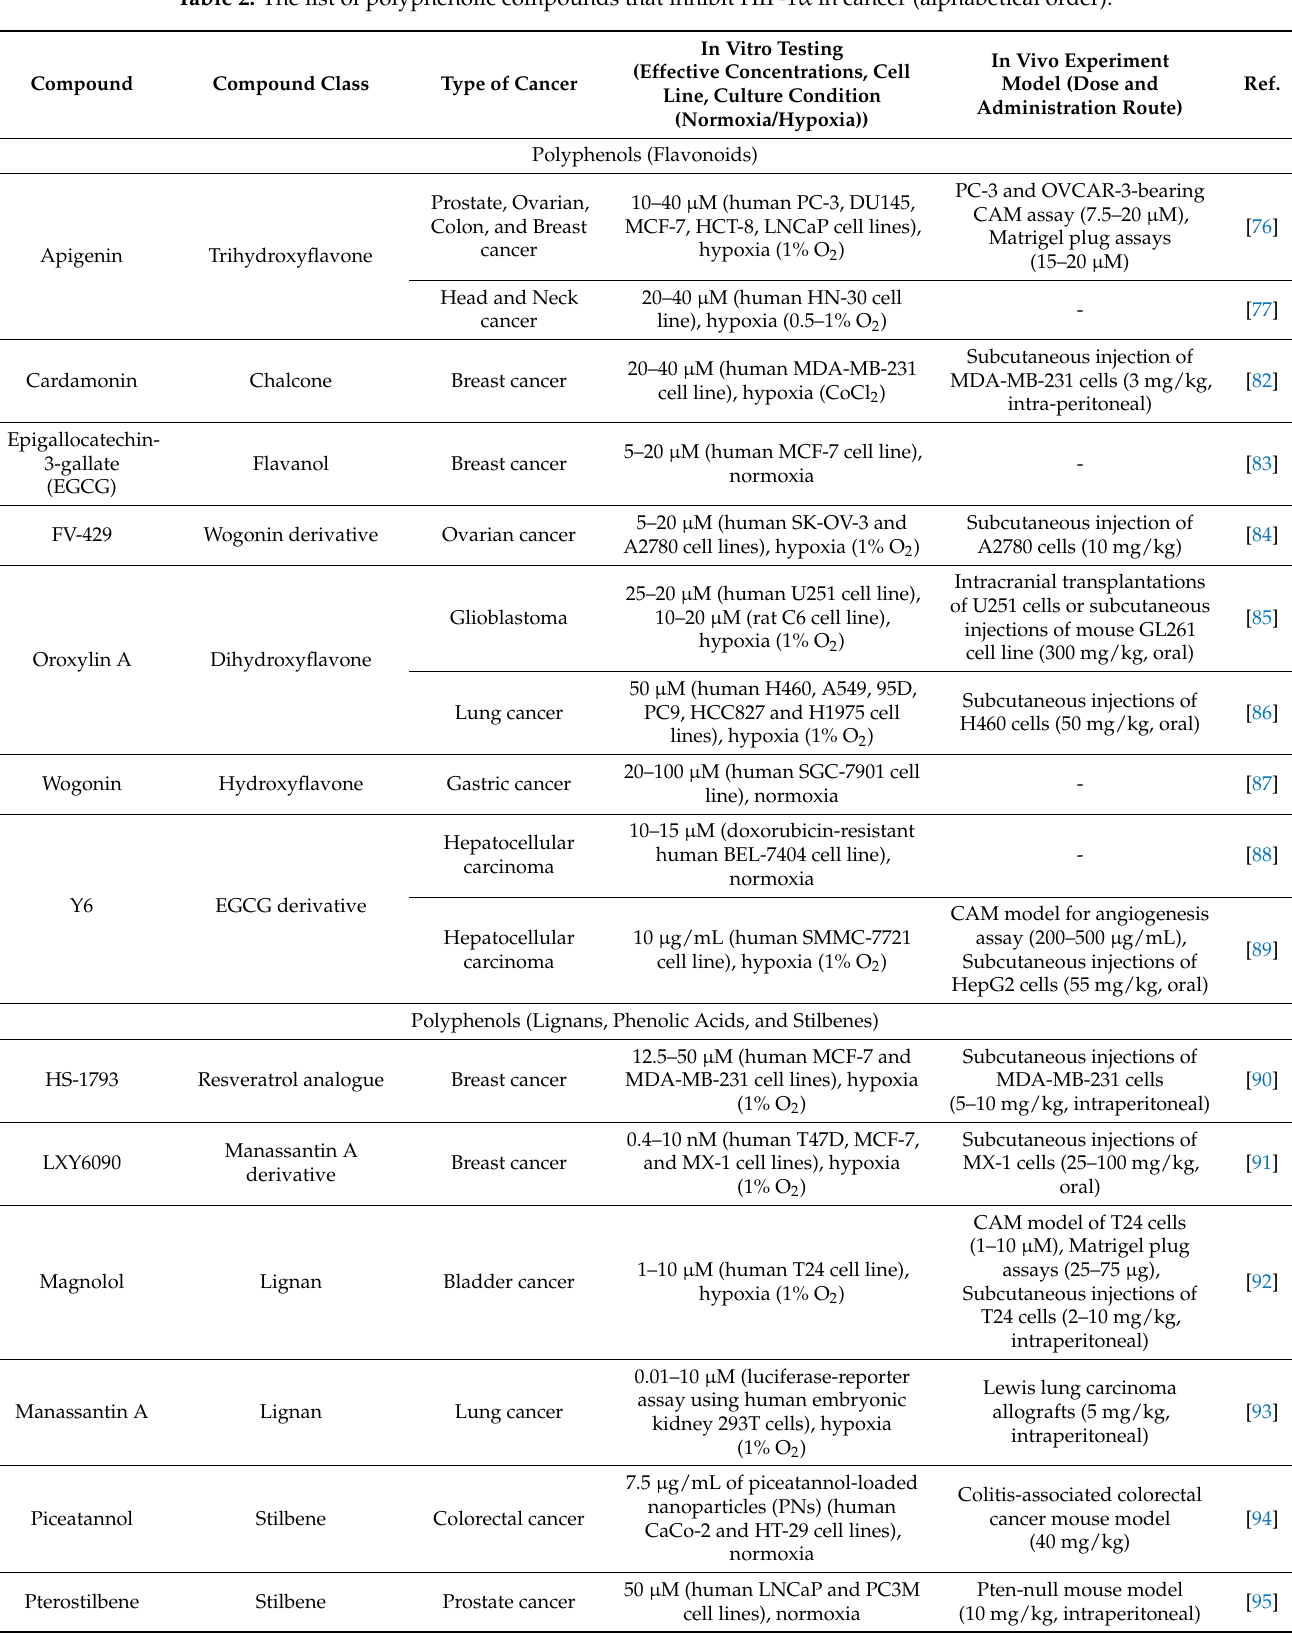
Table 2. The list of polyphenolic compounds that inhibit HIF-1 α in cancer (alphabetical